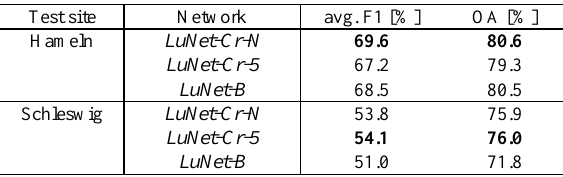
Table 4 . Results of LuNet-Cr-N , LuNet-Cr-5 and LuNet-B based on patches. Number of patches used for evaluation: 289020 (Hameln) / 673215 (Schleswig).